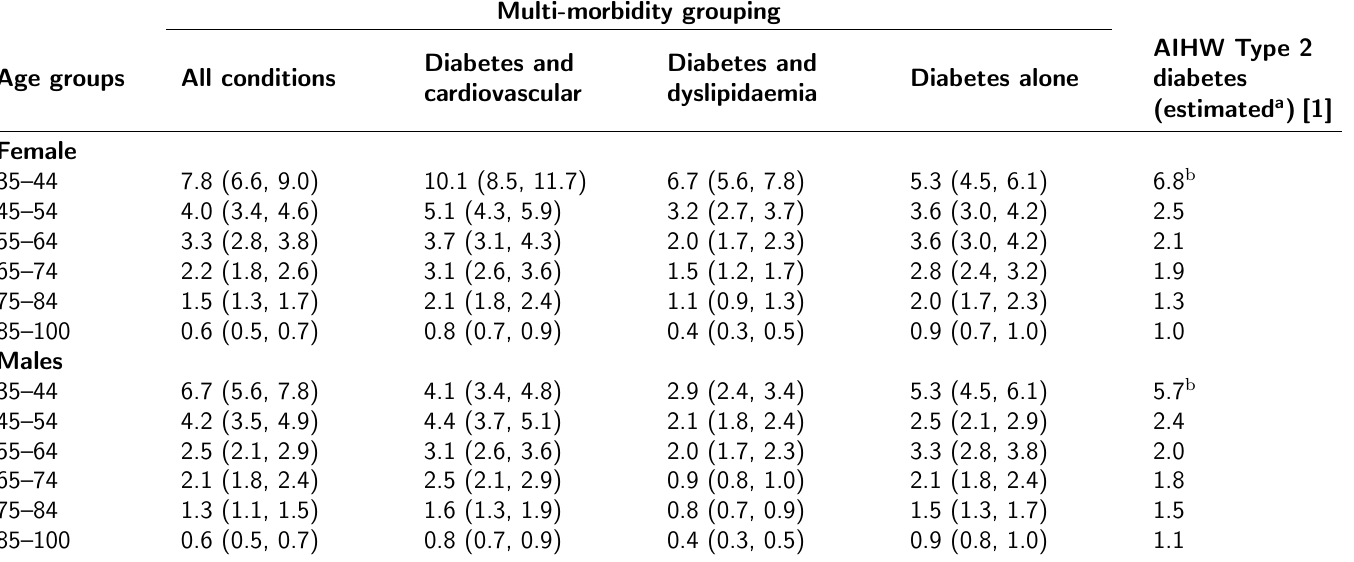
a Estimates extracted from figure data points. b AIHW age group < 45